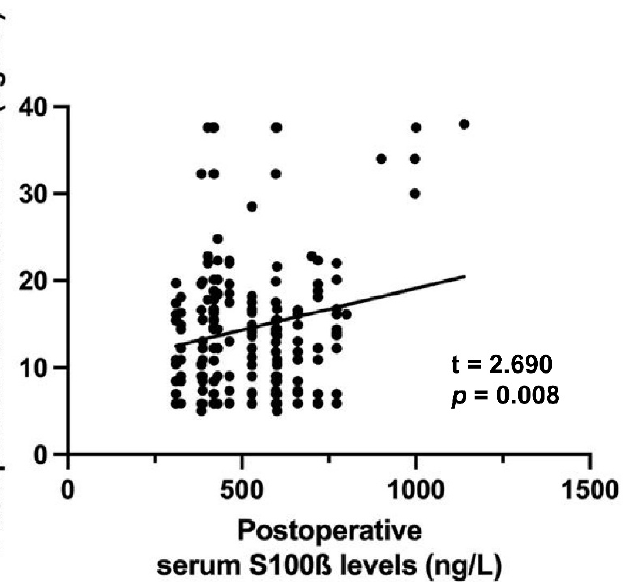
Figure 2. Relationship between postoperative serum NSE levels and serum S100 β levels in older participants undergoing MVD